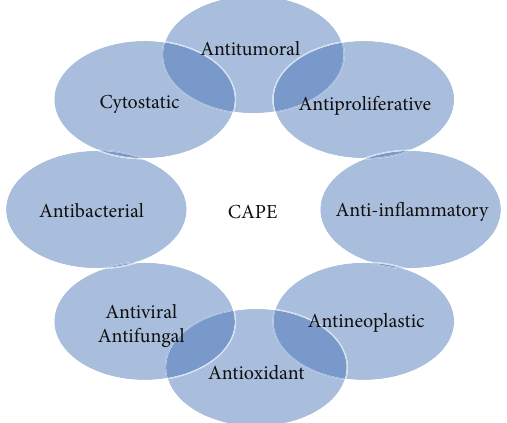
Figure 2: The biological effects of caffeic acid phenethyl ester (CAPE) in vivo and in vitro